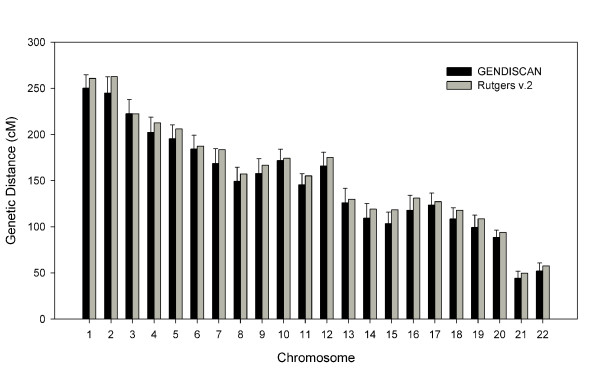
Comparison of sex-averaged genetic lengths of the chromosomes between the GENDISCAN map and Rutgers Map v.2. Error bars represents the 95% confidence intervals from the paired t-tests.